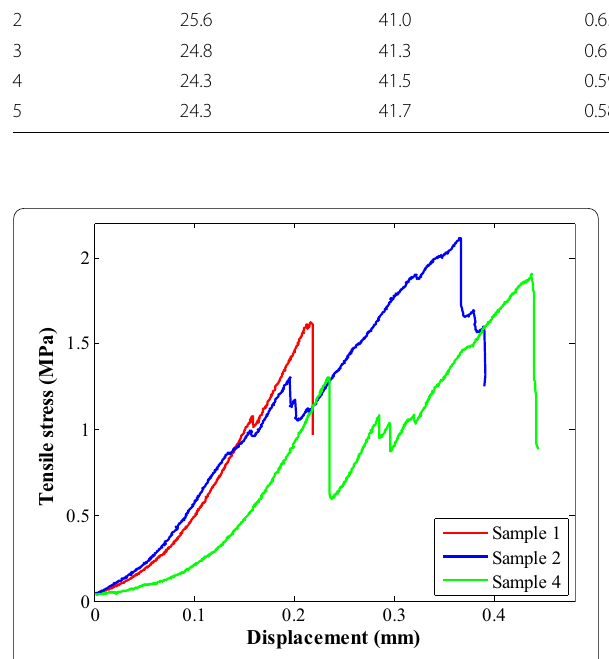
Fig. 5 Tensile stress–displacement curves when the water–cement rate was 0.35.